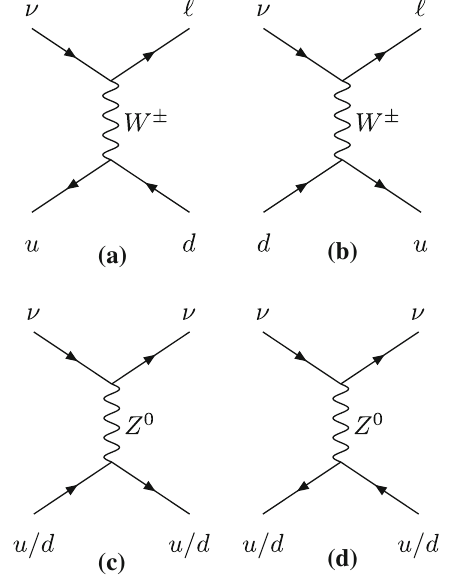
Fig. 11 The parton level W (a/b) and Z (c/d) boson exchange between neutrinos and light